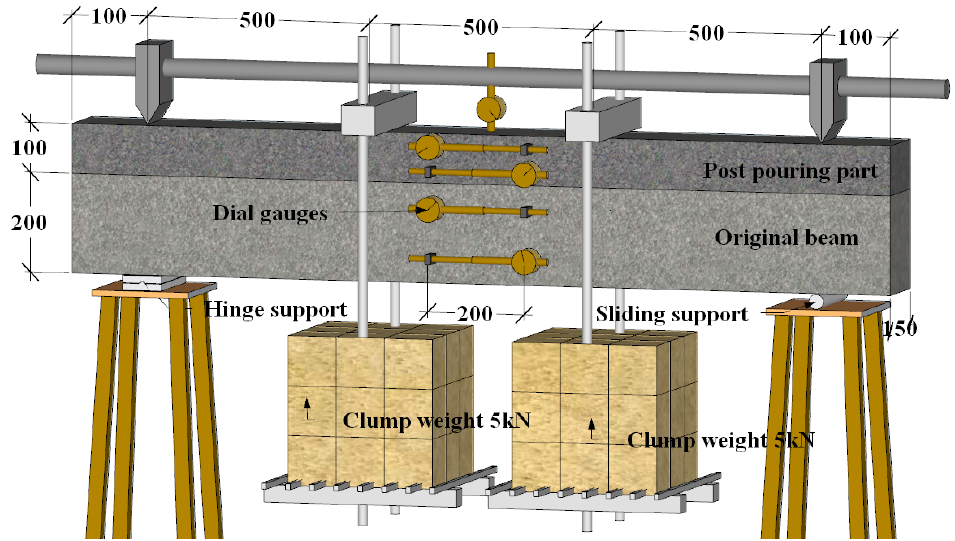
Figure 10. A schematic of the creep test (mm).